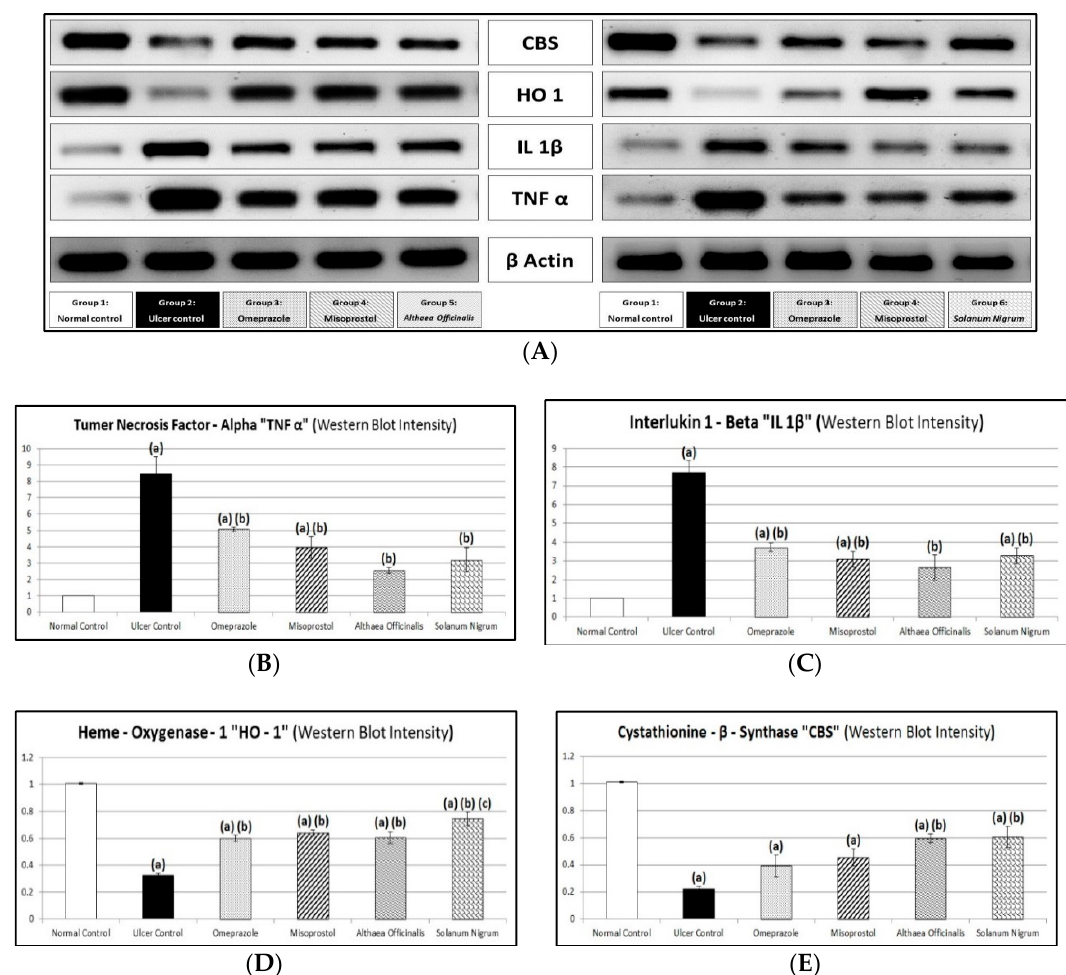
Figure 10. Western blot analysis ( A ) and figure showing protective effects of Althaea officinalis and Solanum nigrum extracts compared to standards misoprostol and omeprazole on tumor-necrosis-factor-alpha “TNF- α ” ( B ), interleukin-1-beta “IL-1 β ” ( C ), heme-oxygenase-1 “HO-1” ( D ), and cystathionine- β -synthase “CBS” ( E ) against pyloric-ligation/indomethacin-induced gastric-ulceration experimentally in male rats. Each value signifies the mean of 6–8 animals ± standard error of the mean. Statistical analysis was performed via one-way ANOVA test, and after that the Tukey–Kramer multiple comparisons test was done. Where: (a) indicates a significant difference from the normal control group ( p < 0.05), (b) indicates a significant difference from the gastric ulcer control group ( p < 0.05), and (c) indicates a significant difference from the omeprazole (1st standard pretreatment) group ( p < 0.05).